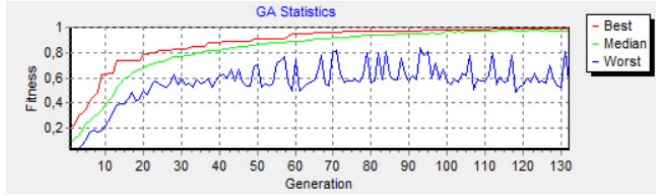
Figure 16. EQCreator computation for special algebra—good.